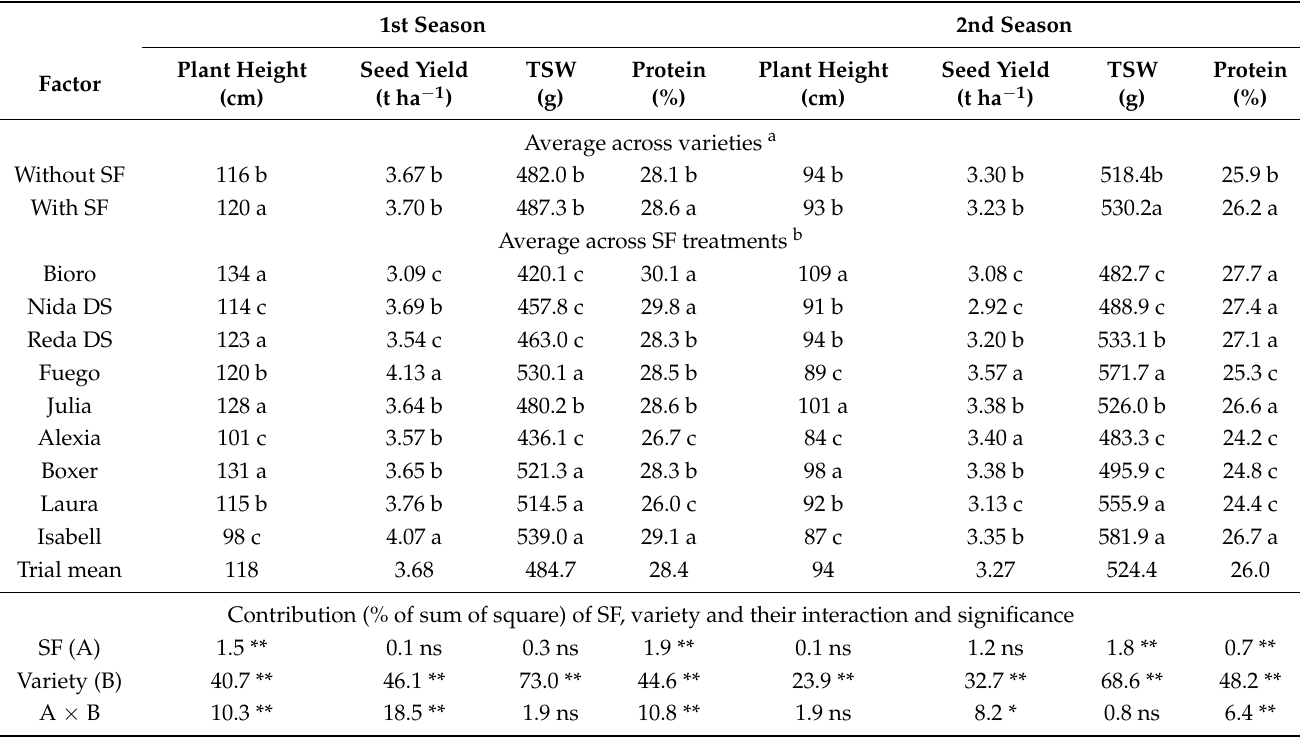
Table 5. Effects of seed fungicide (SF) and variety on seed yield and quality parameters of faba bean, in the first and second